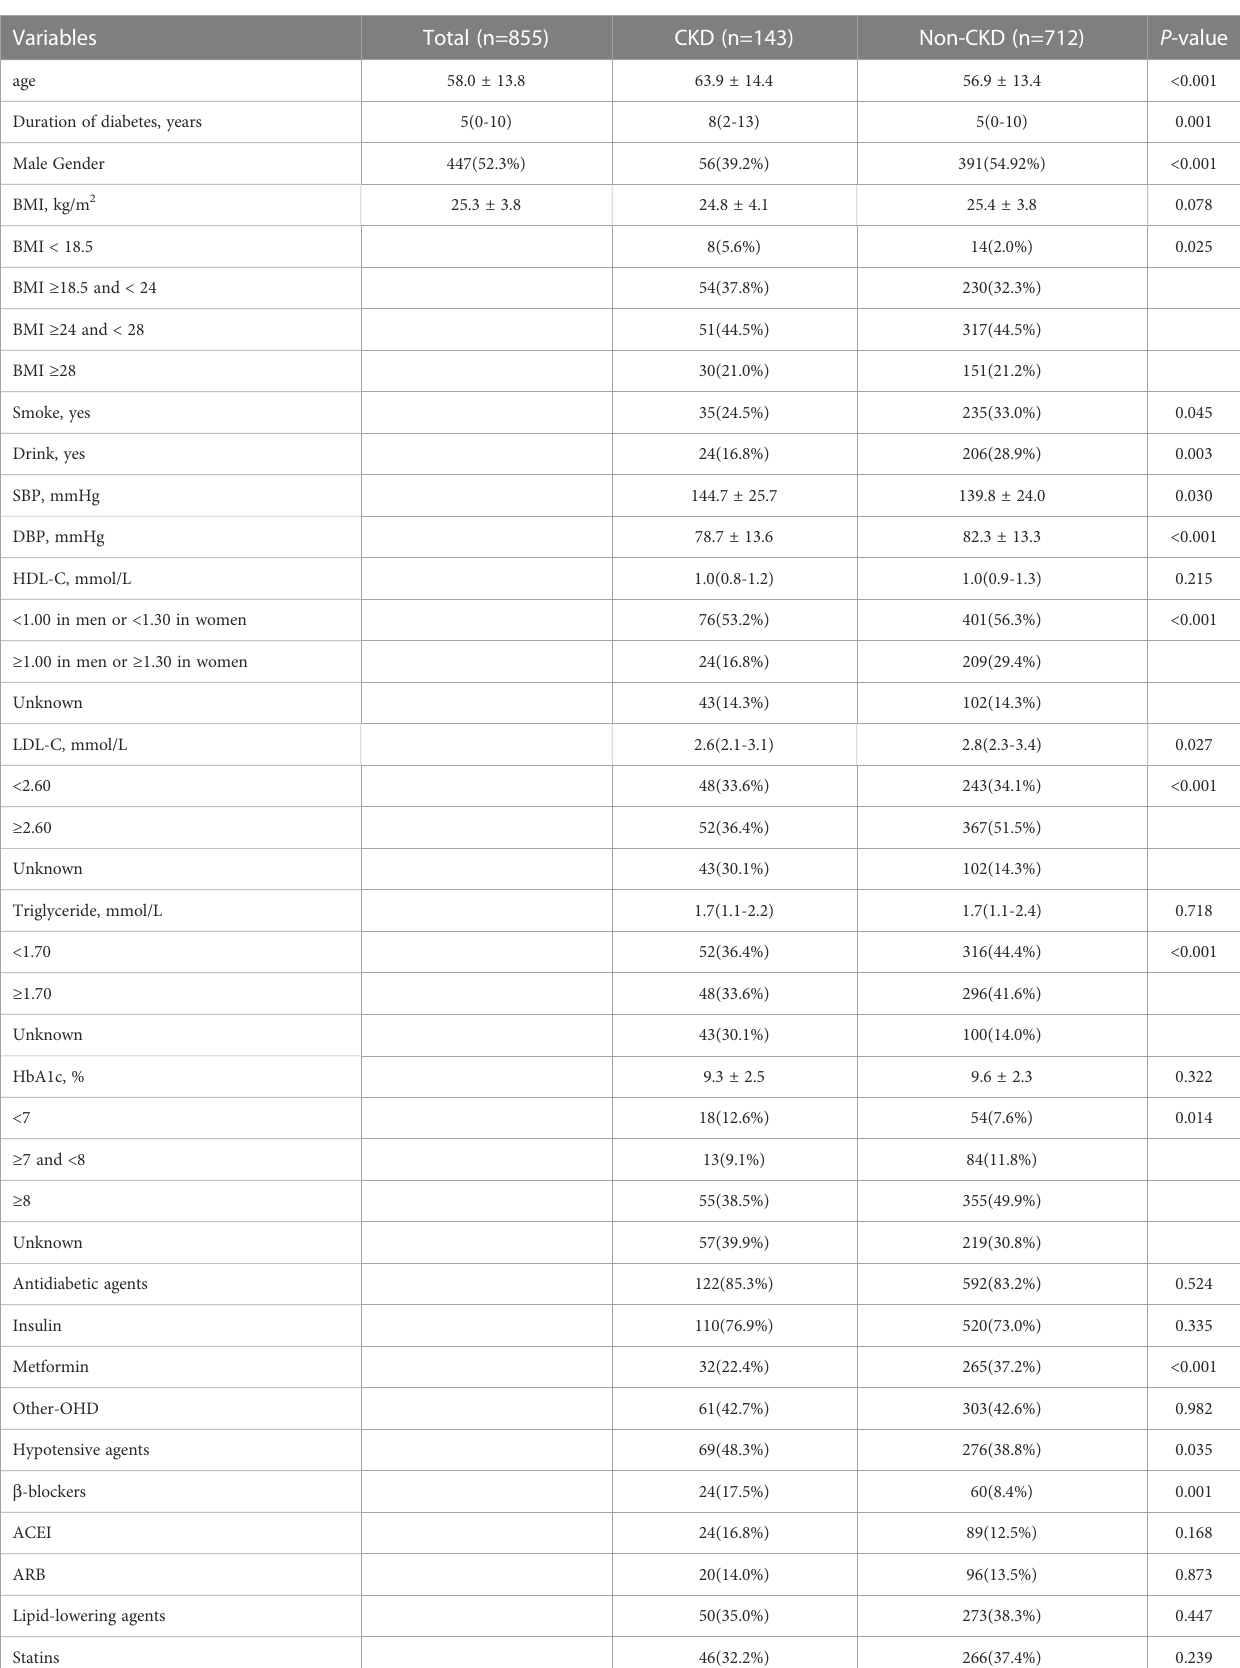
TABLE 1 Clinical and biochemical characteristics of T2DM according to